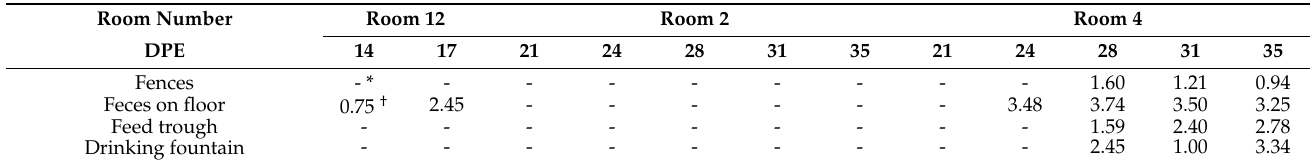
Table 3. CSFV loads of environmental samples from the experimental